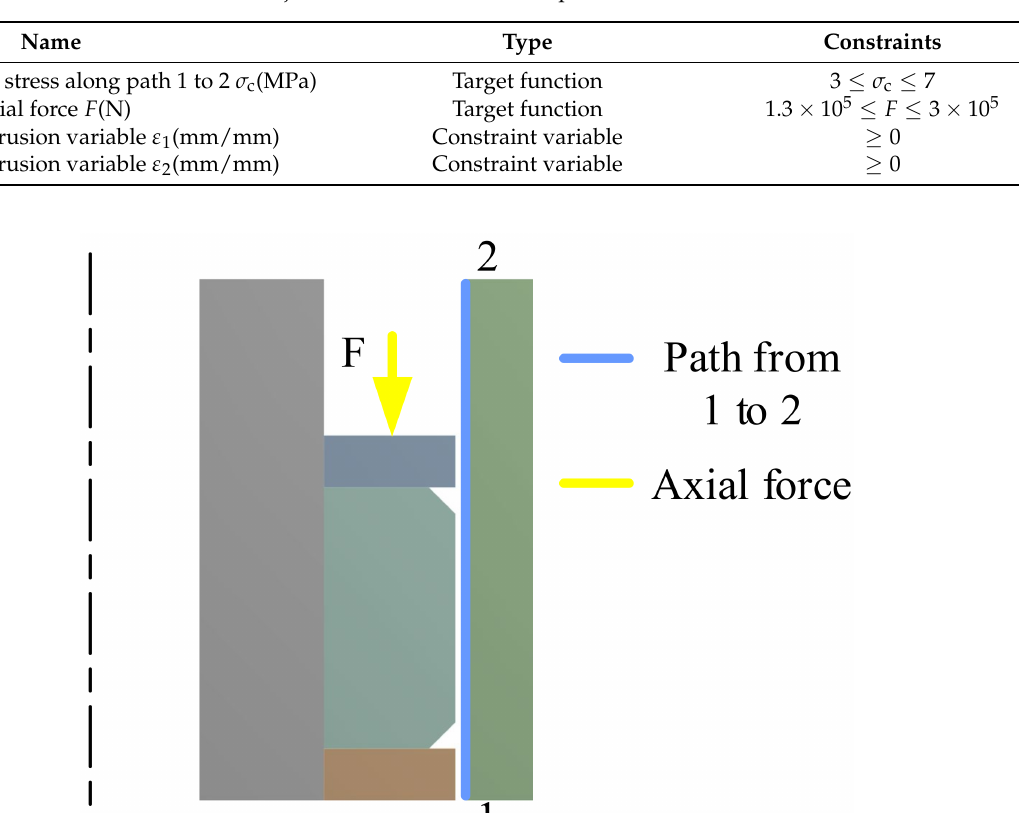
Table 6. The objectives and constraints of optimization.